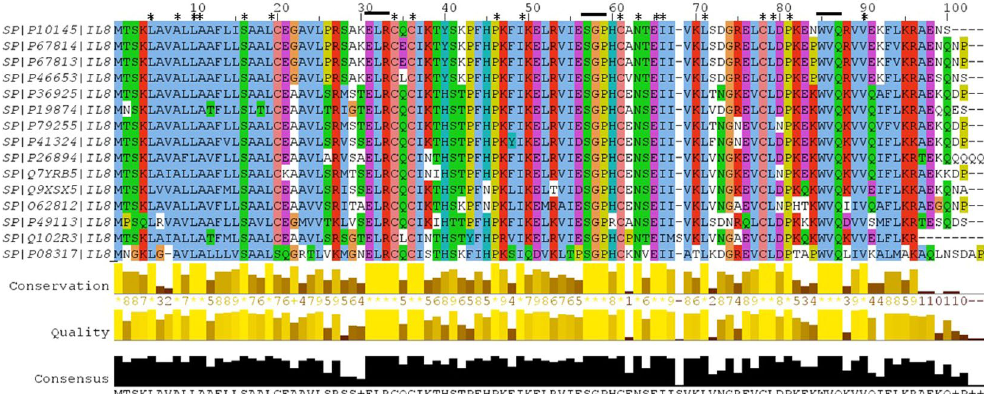
Figure 3. Amino acid alignment of human IL-8 protein (UniProt ID: P10145) along with its homologues in phylogenetically close species in mammals and fouls. Solid horizontal bars indicate conserved sequence motifs and residues with asterisk ( * ) mark indicate evolutionary conserved amino acids. The amino acid identities were colored according the Clustal color scheme, and the conservation index at each alignment position were provided by Jalview 61 .